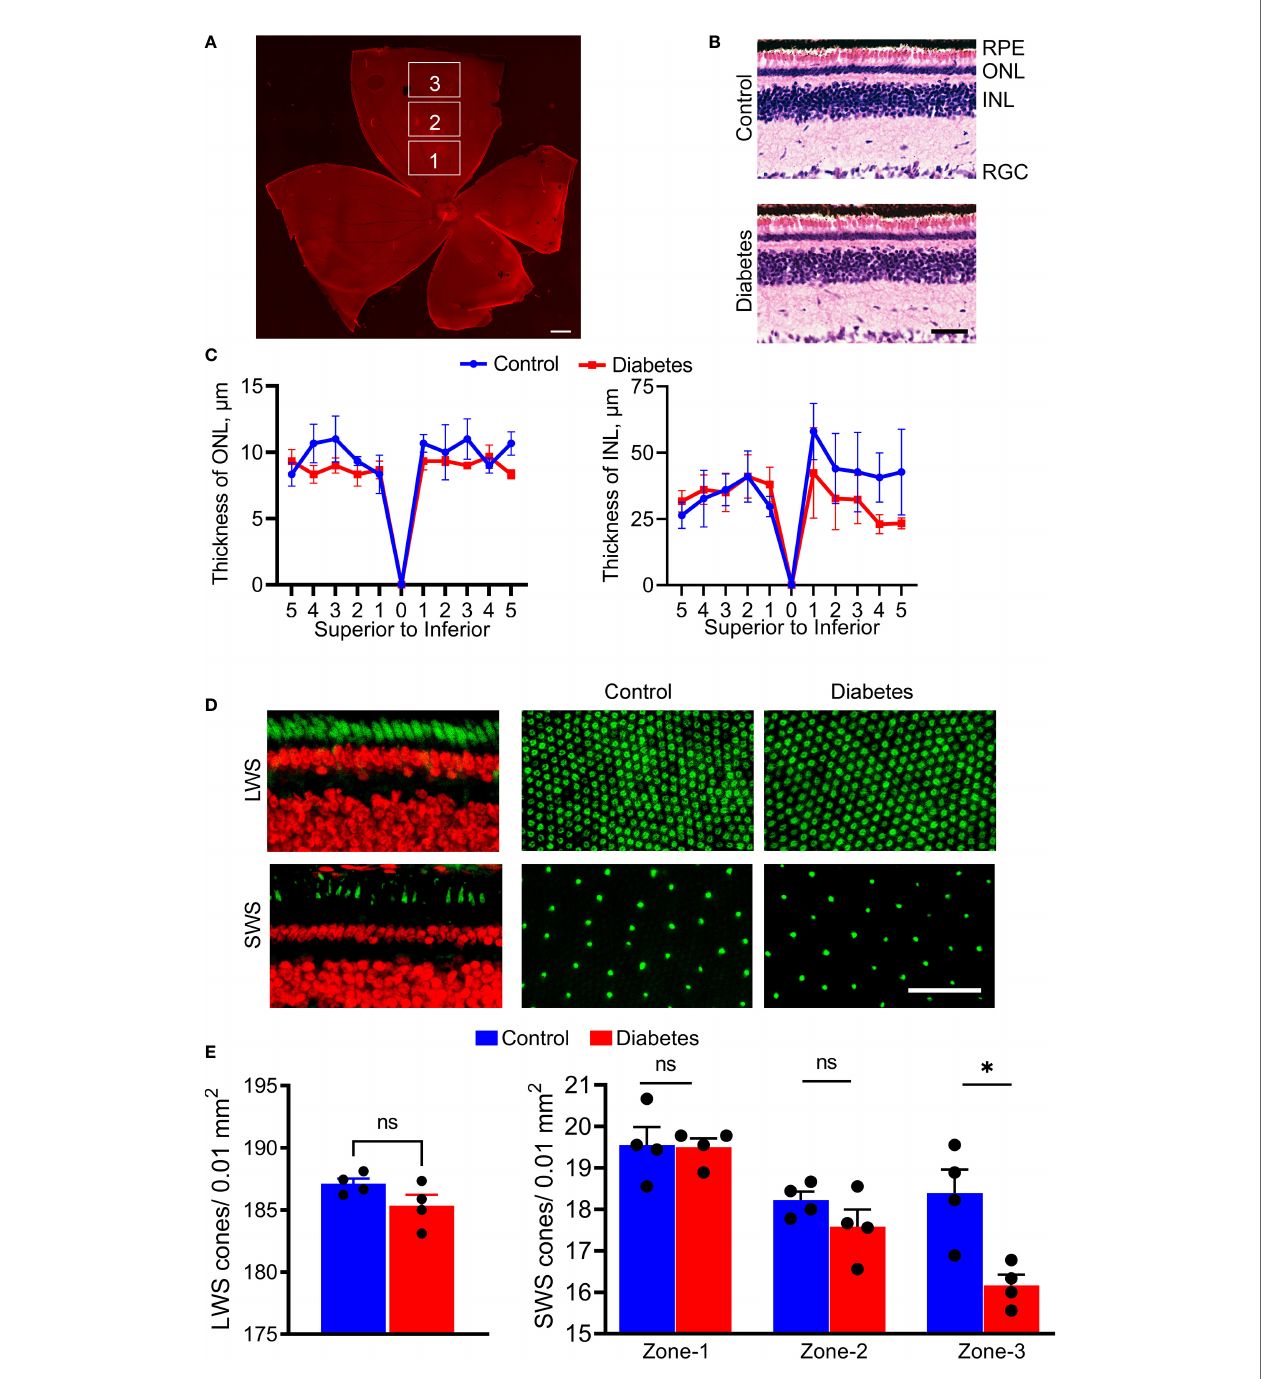
FIGURE 4 | Histological changes of diabetic retinas. (A) The retinal fl at mounts were divided by zone-1, zone-2, and zone-3 to count cone photoreceptor and retinal ganglion cells (propidium iodide in red). (B) Images of the H&E-stained control and diabetic retinas. (C) Spider plots depicting the thicknesses of the ONL and INL. The spider plots were generated by plotting the number of nuclei using 1000 µm step in the distance from the ONH for both hemispheres. (D) Fluorescent images showing sections of the retina and retinal fl at mounts from control and diabetic tree shrews processed with anti-green/red cone opsin (Green, upper panel) and anti- blue cone opsin (Green, bottom panel) primary antibodies, as well as with propidium iodide (Red). (E) The number of LWS cones did not differ between the diabetic and control groups (left graph); however, the number of SWS cones showed small but signi fi cant differences between diabetic and control groups in zone 3 (right graph) . *p < 0.05, (n= 4, each). Scale bars: (A) - 1000 µm, (B, D) – 50 µm. ns, non-signi fi